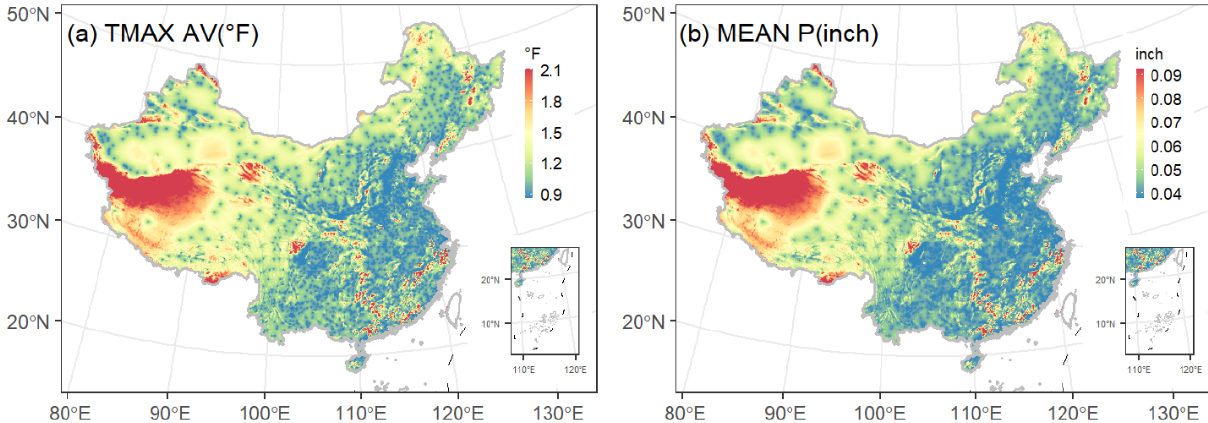
Figure 9. Map of the study area showing the spatial distribution of the standard error for interpolation results of TMAX AV (a) and MEAN P (b) using universal kriging.